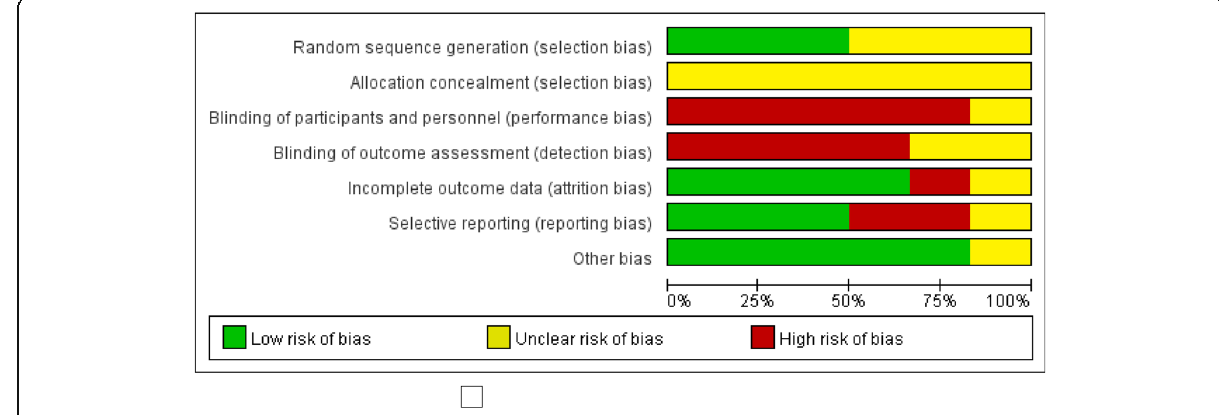
Fig. 3 Risk of bias of studies included in the meta-analysis on effect of electroacupuncture to MCI